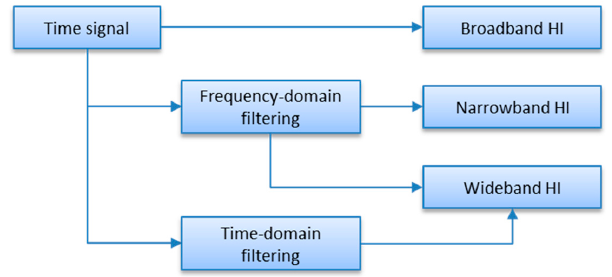
Sensors 2023 , 23 , x FOR PEER REVIEW Figure 1. Calculation paths of scalar machine health indicators. Figure 1. Calculation paths of scalar machine health indicators.